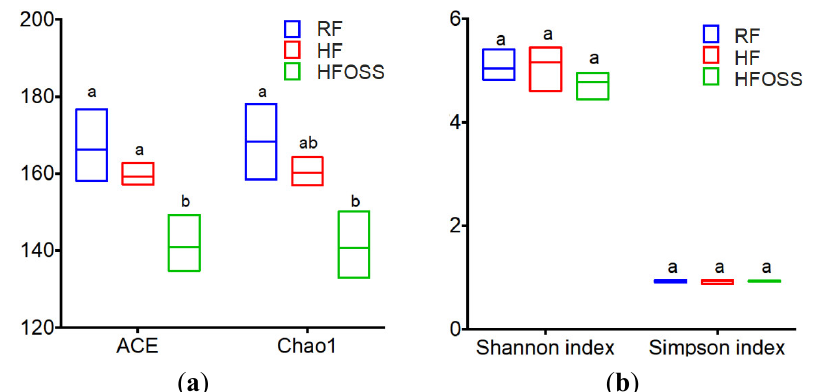
Figure 8. Boxplots of between-group α -diversity comparison. ( a ) ACE index and Chao 1 index boxplots as well as ( b ) Shannon index and Simpson index boxplots of the regular-fat diet group (RF), high-fat diet group (HF), and high-fat diet supplemented with OS starch group (HFOSS). Each box diagram shows the minimum, first quartile, medium, third quartile, and maximum values of the index of the corresponding group. Different letters indicate significant differences between groups ( p < 0.05).